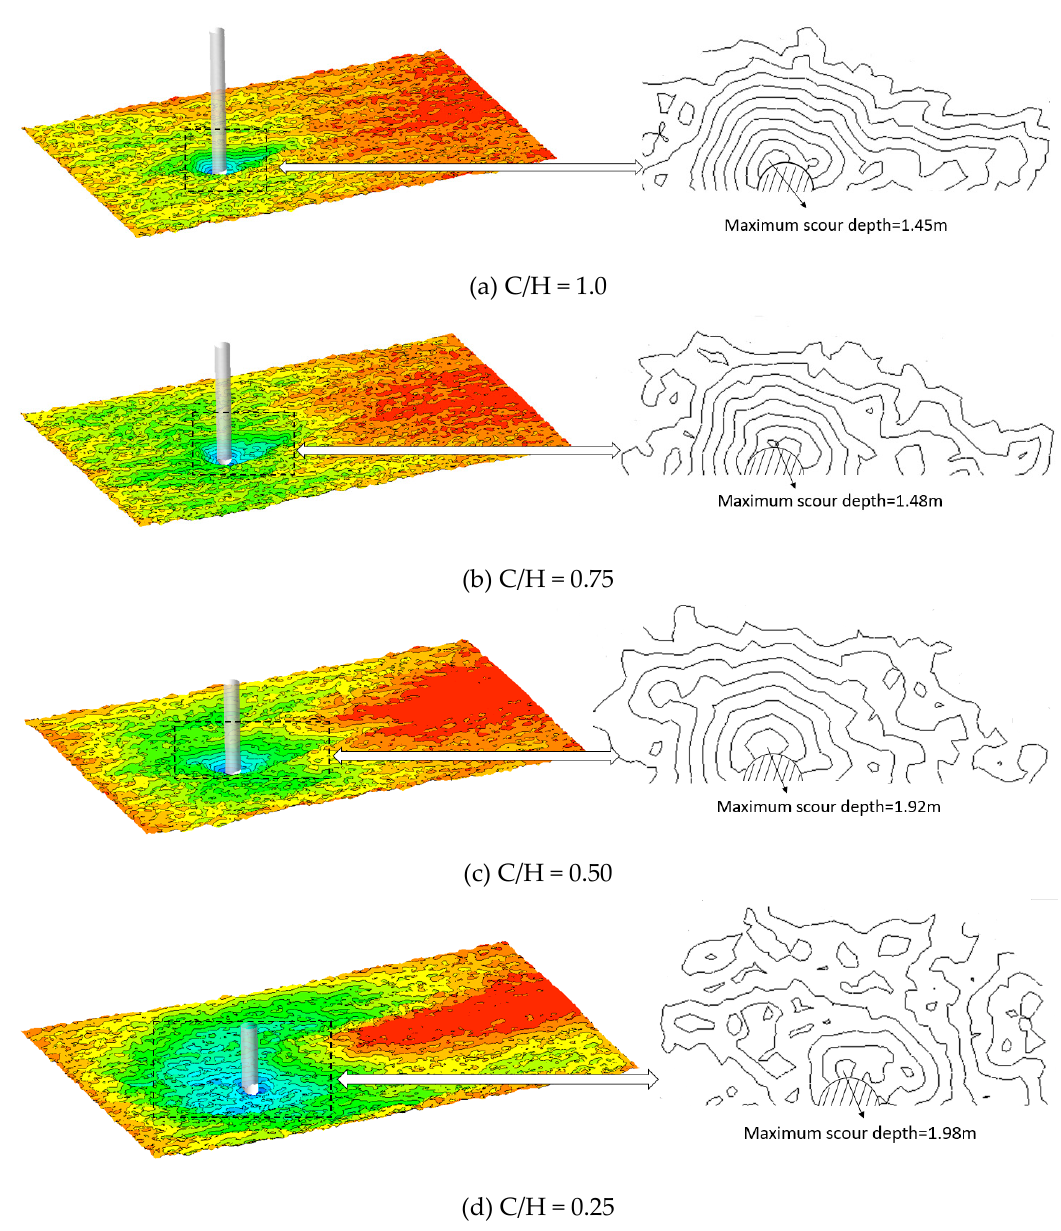
Figure 11. Equilibrium scour profiles with foundation piles for different tip clearances: ( a ) C / H = 1.0; ( b ) C / H = 0.75; ( c ) C / H = 0.5; and ( d ) C / H = 0.25. The maximum scour depth was 1.45 m, 1.48 m, 1.92 m, and 1.98 m for C / H = 1.0, 0.75, 0.5, and 0.25, respectively. The pile diameter was 1.0 m. The flow moves from left to right.